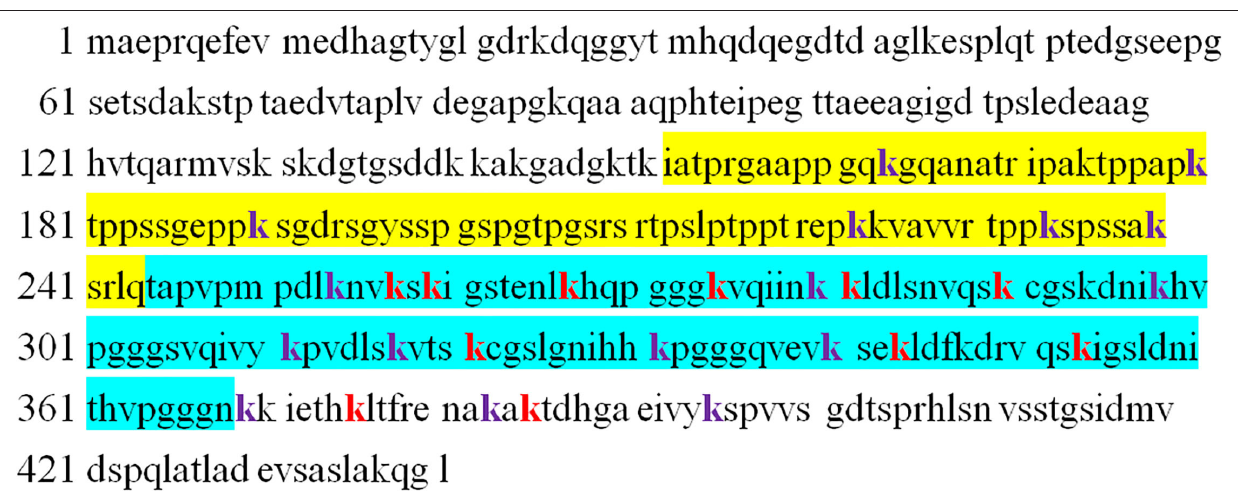
FIGURE 1 | The sequence of 2N4R-tau with identified ubiquitinated sites (both purple and red, k). The yellow sequence indicates proline-rich domain, whereas cyan indicates microtubule-binding repeat domain. Chip ubiquitinates tau at sites shown by red color.